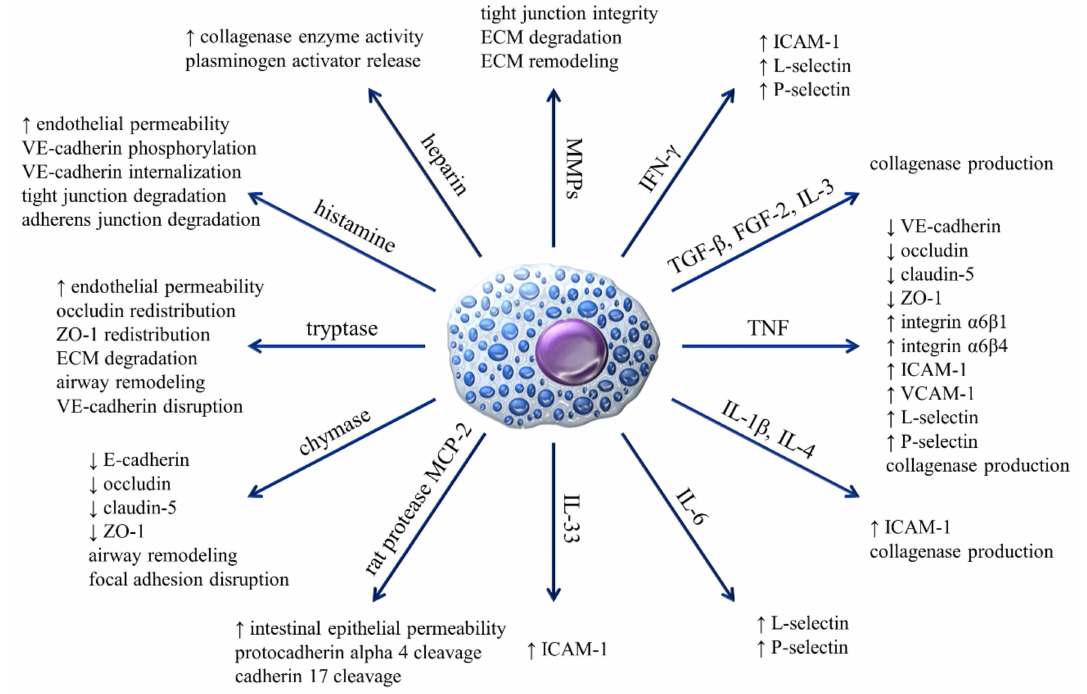
Figure 1. The influence of MCs and their mediators on the expression of adhesive molecules and regulation of processes related to the phenomenon of